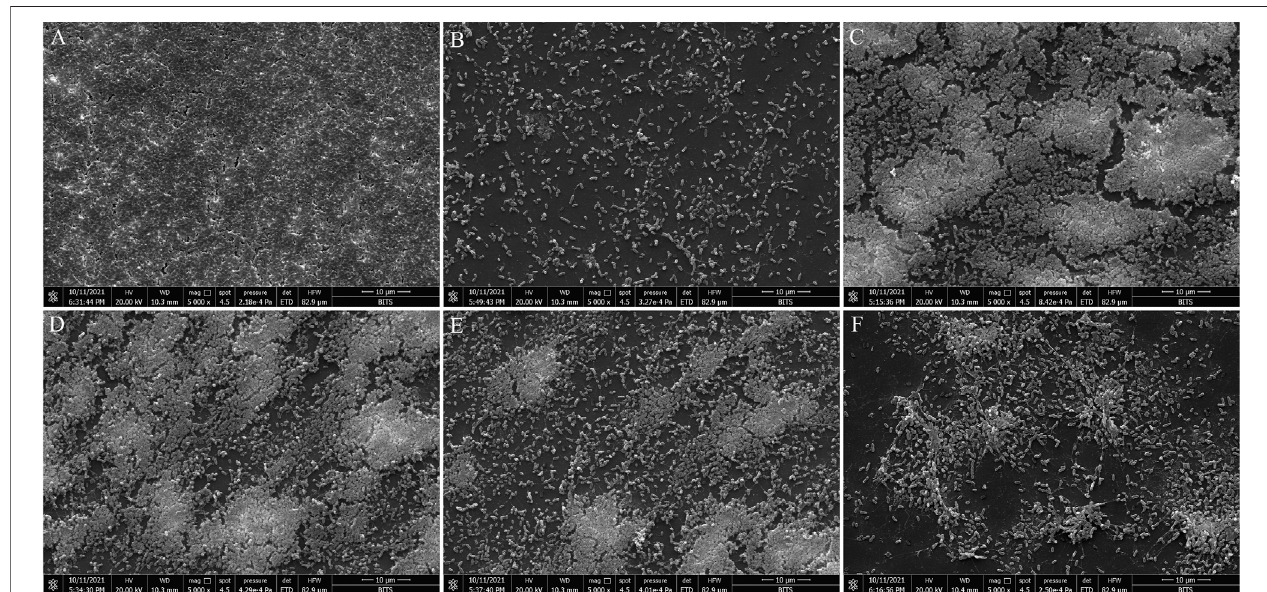
FIGURE 4 | Scanning electron microscopy analysis. SEM images of inhibition of P. aeruginosa bio fi lms treated with DMSO (A) , salicylic acid, 10 mM (B) , BG138, 8 μ g/ml (C) , 12 μ g/ml (D) , 16 μ g/ml (E) , and 20 μ g/ml (F) .